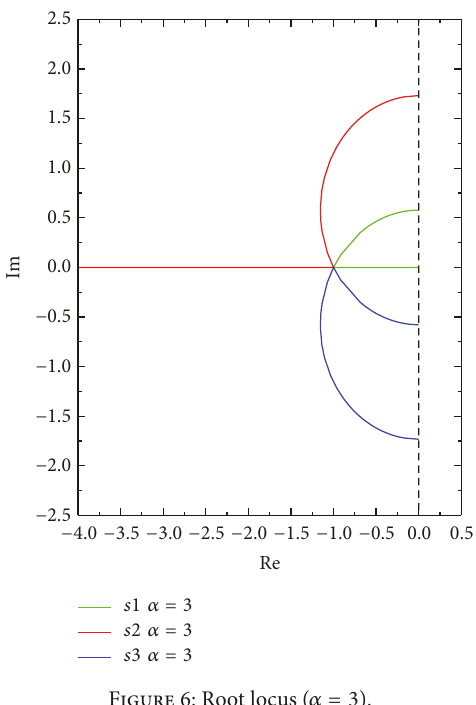
Figure 6: Root locus ( 𝛼 = 3 ).